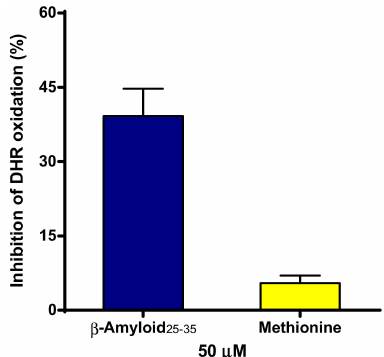
Figure 6. E ff ect of A β 25-35 and L-Met on DHR oxidation mediated by carbonate radical anion. A β 25-35 or L-methionine (50 µ M final concentration) was added to a solution containing 25 µ M DHR, 31 µ M SOD, 0.1 mM DTPA, and 25 mM sodium bicarbonate in 0.2 M phosphate bu ff er, pH 7.4. Reaction was started by the addition of 1 mM H 2 O 2 . Oxidized DHR was quantified spectrophotometrically at 500 nm.